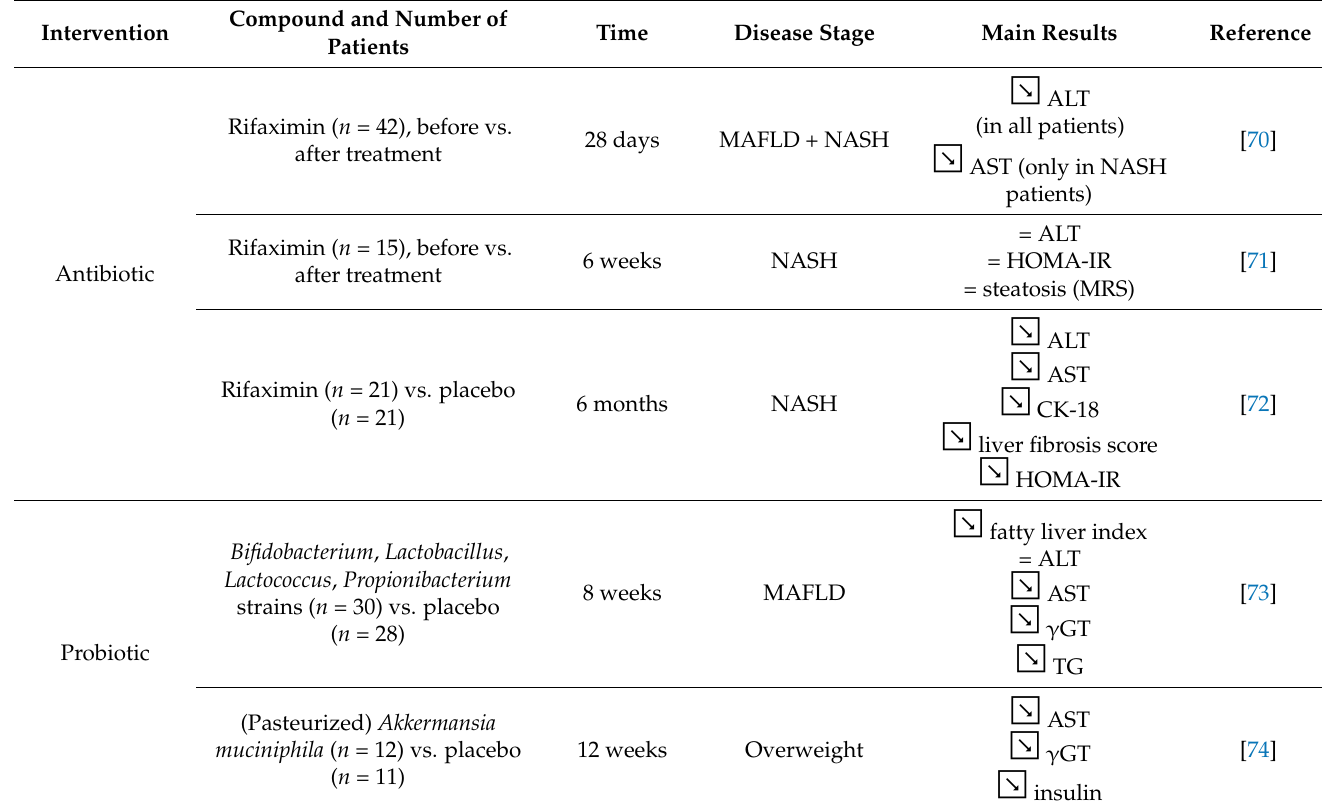
Table 3. Clinical trials with antibiotics, probiotics, prebiotics, synbiotics or fecal microbiota transplantation in metabolic dysfunction-associated fatty liver disease (MAFLD) or non-alcoholic steatohepatitis (NASH).